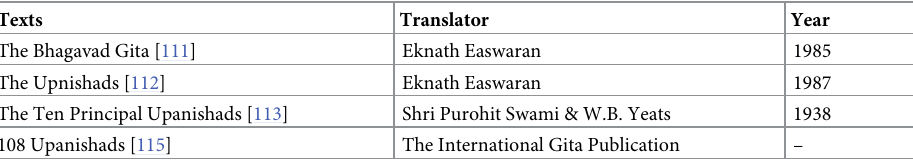
Table 1. Details of the texts used for topic modelling.